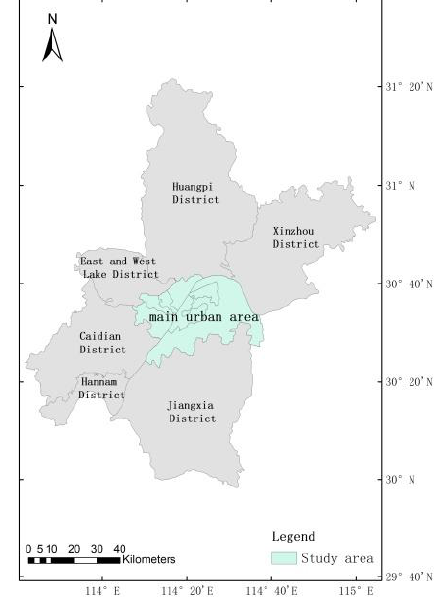
Figure 1. Location of the study area.